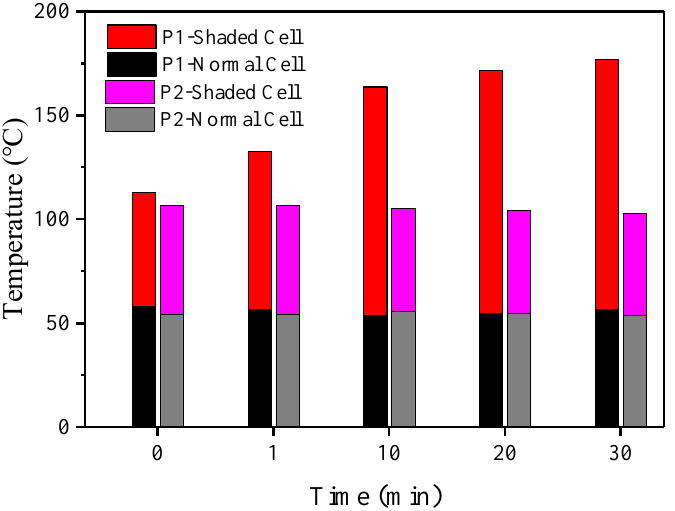
Figure 7. Temperature change with shading time for the PV module at different working points (The temperatures reported in the figure are read from the IR camera images in Figure 6. Temperature of normal cell and shaded cell correspond to SP1 and SP2, respectively. P1 and P2 in the legend refer to Peak 1 and Peak